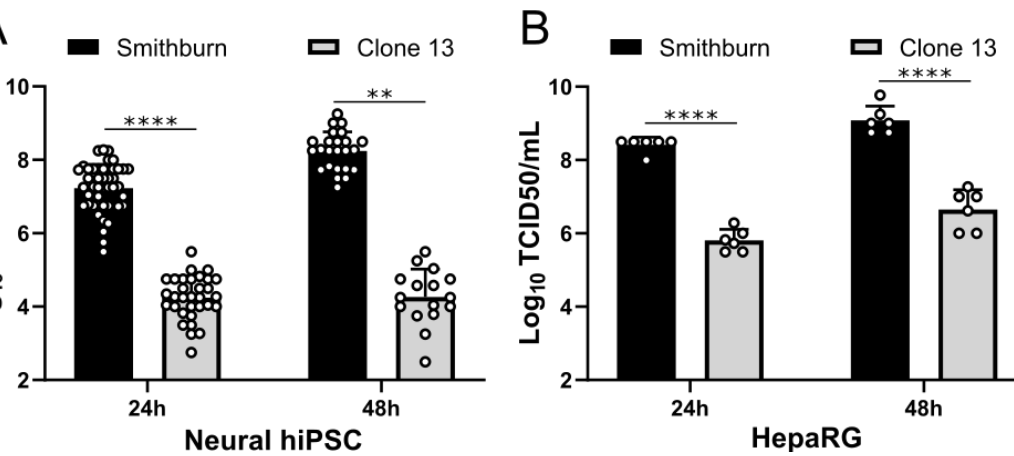
Figure 5. SB displays a high replication capacity in human neural and hepatocyte cells. Growth curves experiments were performed in neural-differentiated human pluripotent stem cells (neural hIPSC; MOI = 0.1) ( A ) and human hepatocytes cell line (HepaRG; MOI = 0.001) ( B ) infected with SB and Cl.13. Cell supernatants were collected at 24 h and 48 h p.i., and virus titers were obtained by limiting dilution assays on BSR cells and expressed as log10 50% tissue culture infective doses (TCID50)/milliliter. Circles represent the viral titers obtained from independent experiments per- formed in triplicate and repeated three times. Bars indicate standard deviations. Statistical analyses were performed using Kruskal–Wallis (**: p < 0.01; ****: p < 0.0001).